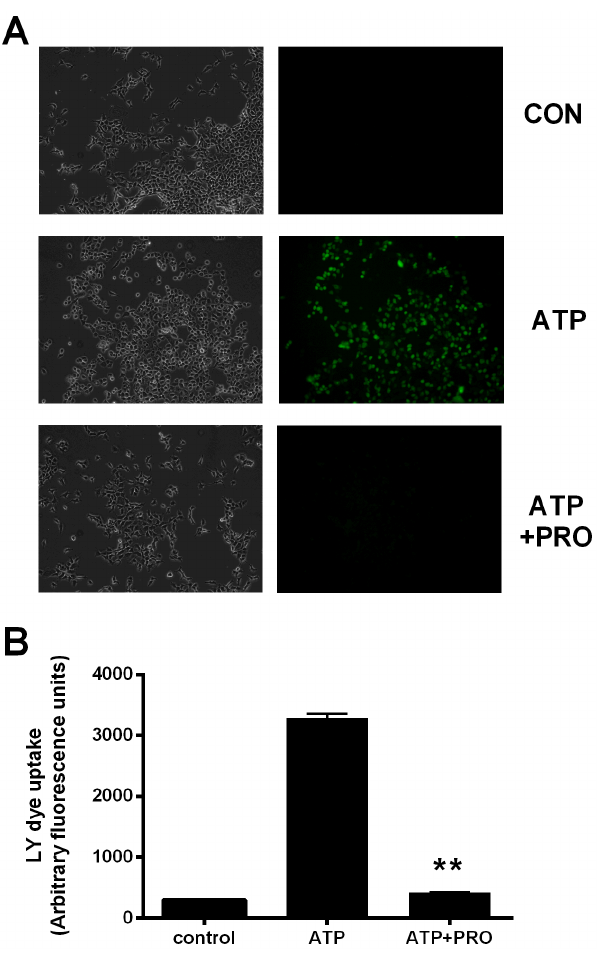
Figure 5. Probenecid blocks lucifer yellow uptake in HEK- hP2X7 cells. Lucifer yellow (0.25 mg/ml) uptake in response to P2X7 stimulation by ATP (3 mM) was measured using a fixed time incubation at 37 u C. Coverslips were briefly washed in standard extracellular solution before being imaged. (A) Phase contrast and fluorescent images for each stimulation condition; Control, ATP (3 mM) and ATP + PRO (2.5 mM) and (B) mean data from 100–300 cells (regions of interest) from multiple images.